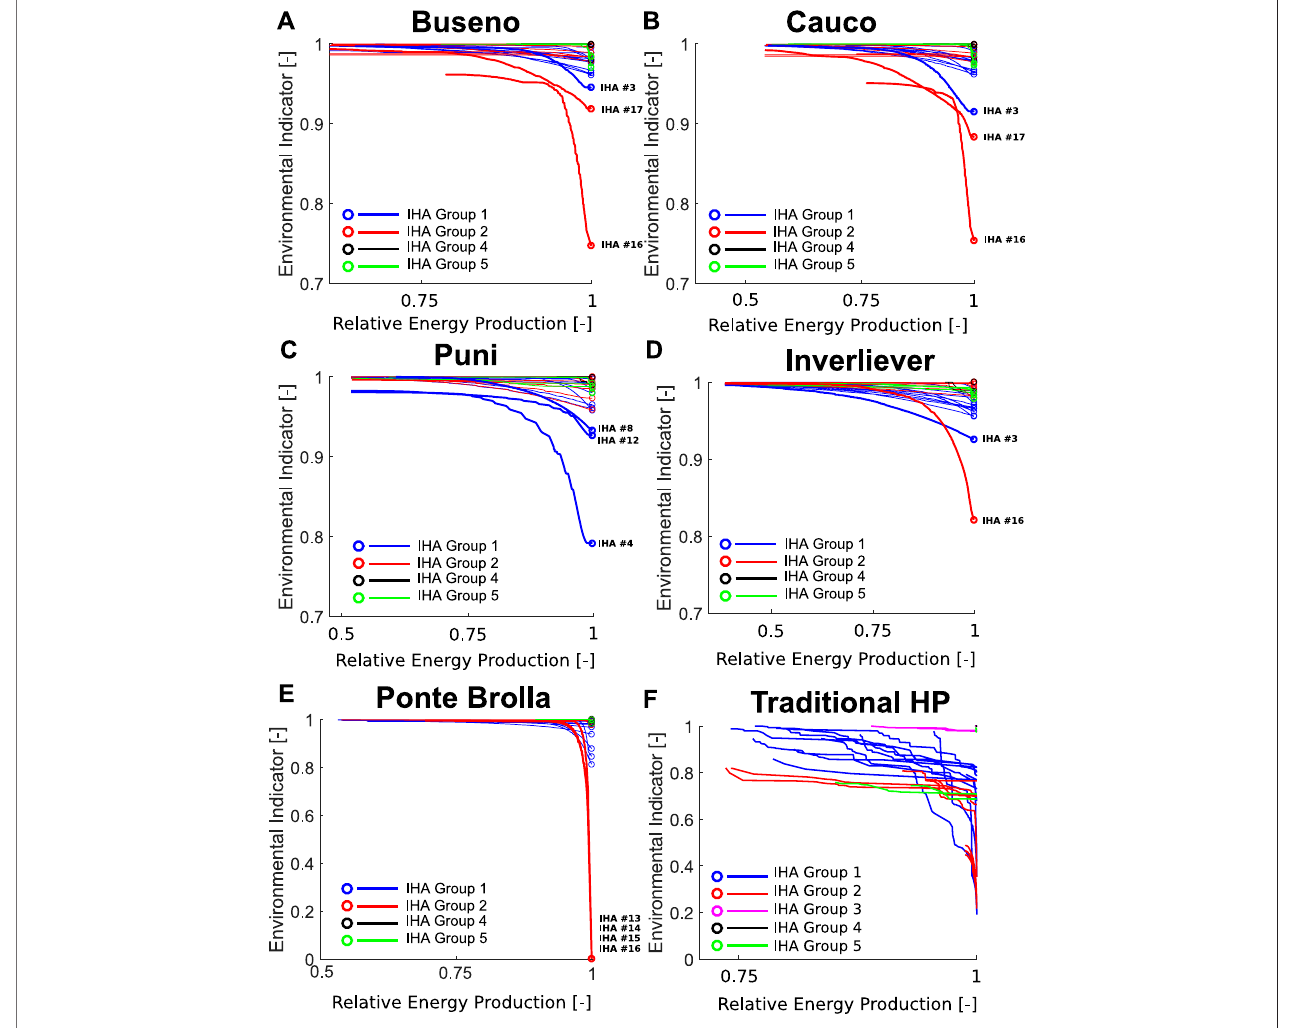
FIGURE 4 | Pareto Frontier resulting from non-proportional policies for each of the 32 IHA sub-indicators. Dots represent Q mfr policies. Each color refers to one of the fi ve groups of hydrological sub-indicators described in Table 1 . Plots (A) , (B) , (C) , (D) and (E) show the results for fi ve different SHP and (F) for a traditional Hydropower Plant. The widest curves represent the IHA with the highest variability for each case study, as summarized in Table 4 .